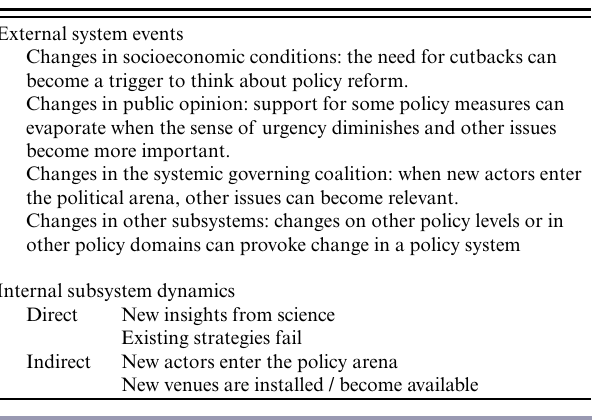
Table 1 . Sources of policy change.